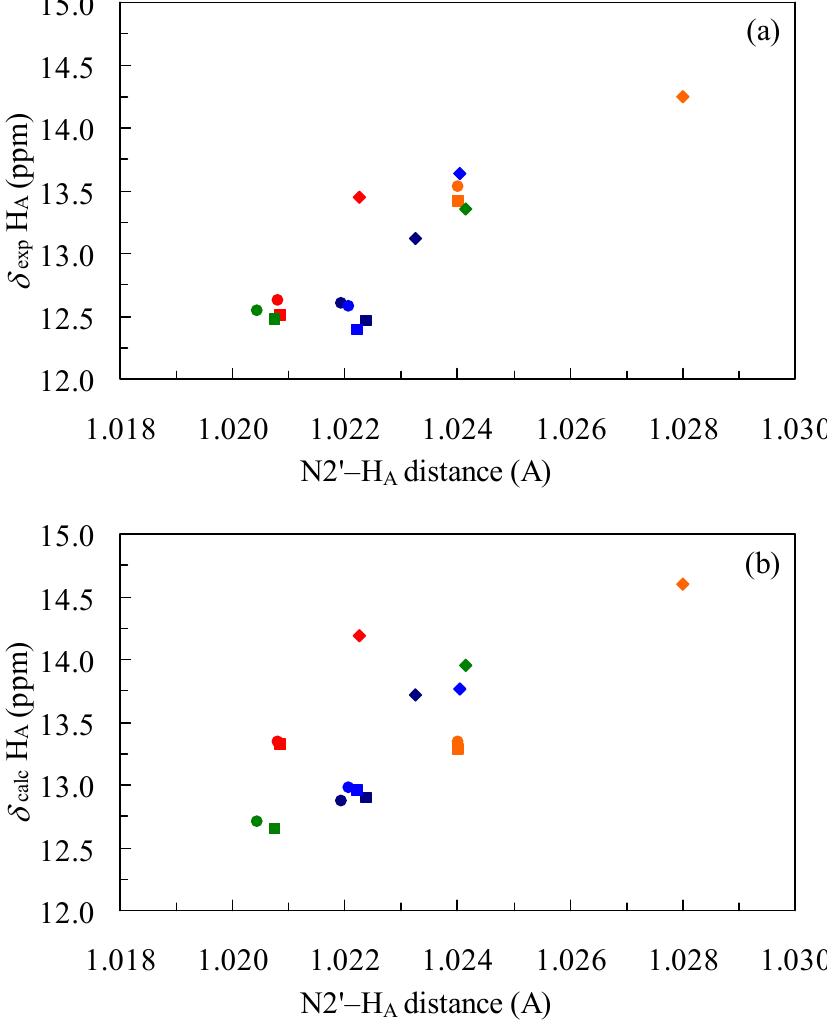
Fig. 8 Plots of experimental (a) and calculated (b) 1 H NMR chemical shift of H A vs. the N2 (cid:2) –H A internuclear